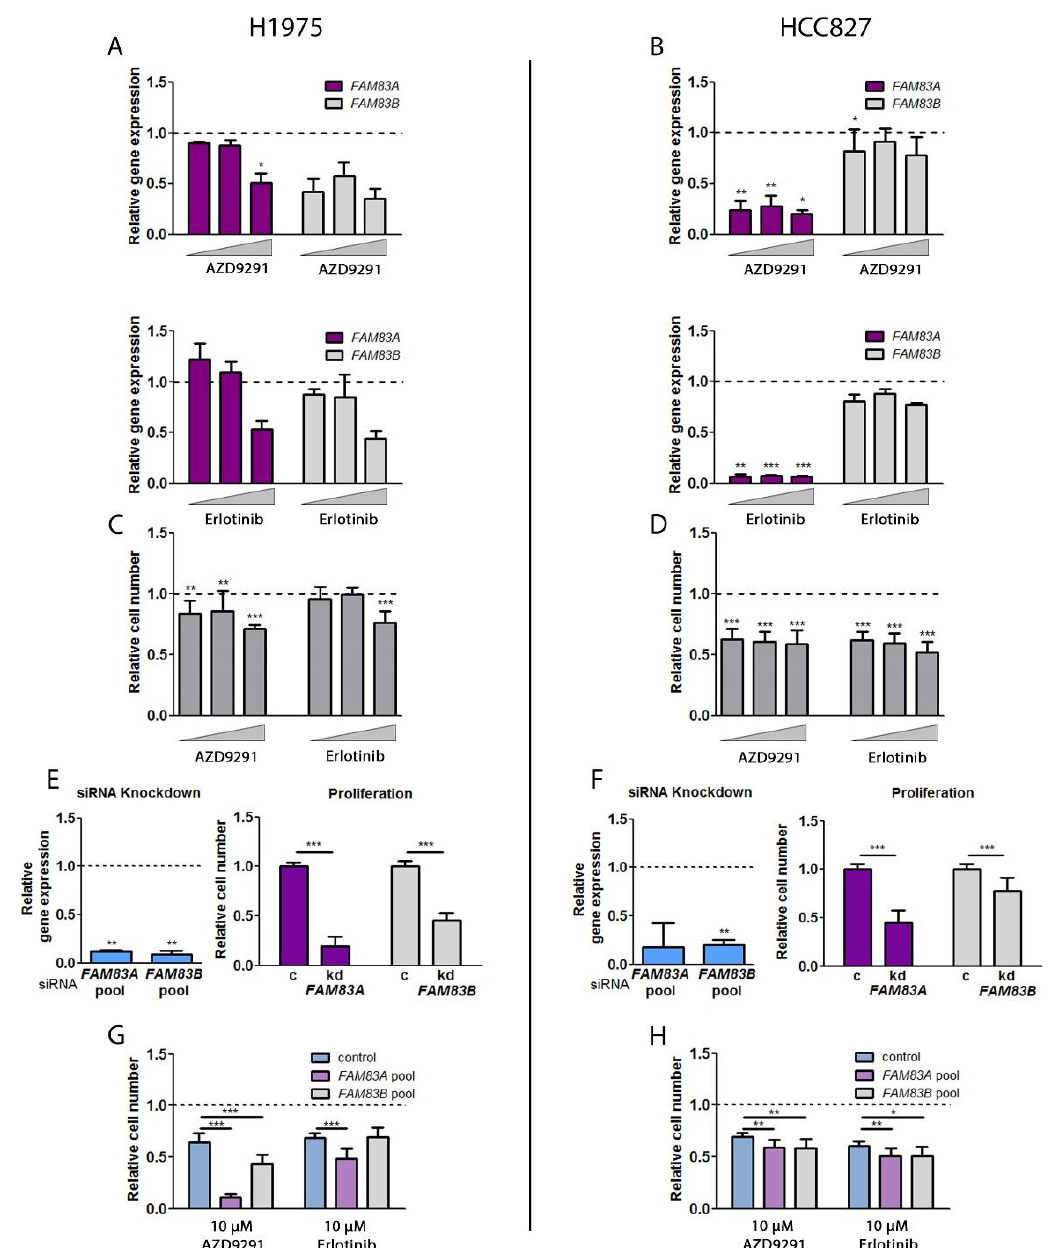
Figure 5. Relation between FAM83A and B and the EGFR pathway in ADC cell lines. ( A ) Gene expression of FAM83A and B after treatment with the tyrosine kinase inhibitors (TKIs) AZD9291 and erlotinib in H1975 and ( B ) in HCC827. The TKIs were applied at concentrations of 0.1 µM, 1 µM, and 10 µM for 24 h. ( C ) Effect of TKI treatment on cell viability in H1975 and ( D ) HCC827 cells. ( E ) siRNA-mediated depletion of FAM83A and B and its impact on cell proliferation in H1975 and ( F ) HCC827 (Relative cell number after FAM83 knockdown (kd) compared to control (c)). ( G ) Influence of FAM83A and B depletion on TKI treatment in H1975 and ( H ) HCC827 cells. The dotted line at 1 represents either the expression ( A , B , E , F ,) or the cell number ( C , D , G , H ) in control-treated cells. At least three independent biological replicates were used. Significance of expression and cell viability variation were estimated using unpaired t -test (*** p < 0.0001; ** p < 0.005; * p < 0.05).